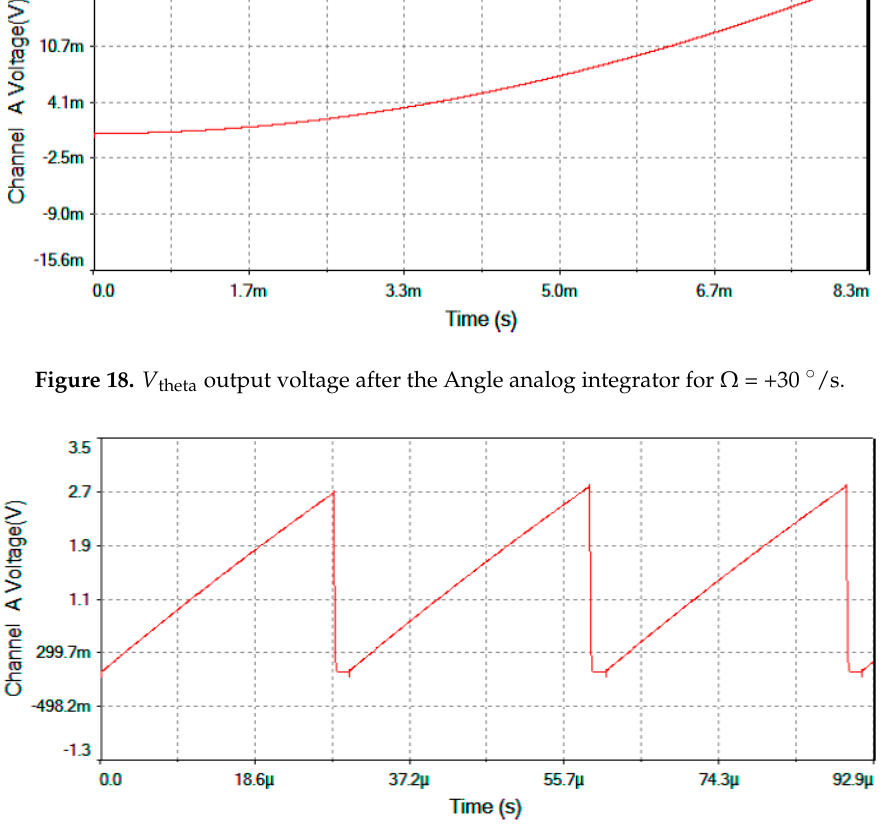
Figure 19. V serrodyne after the Analog Integrator (feedback voltage signal to the Phase-Modulator) for Ω = +30 °/s.